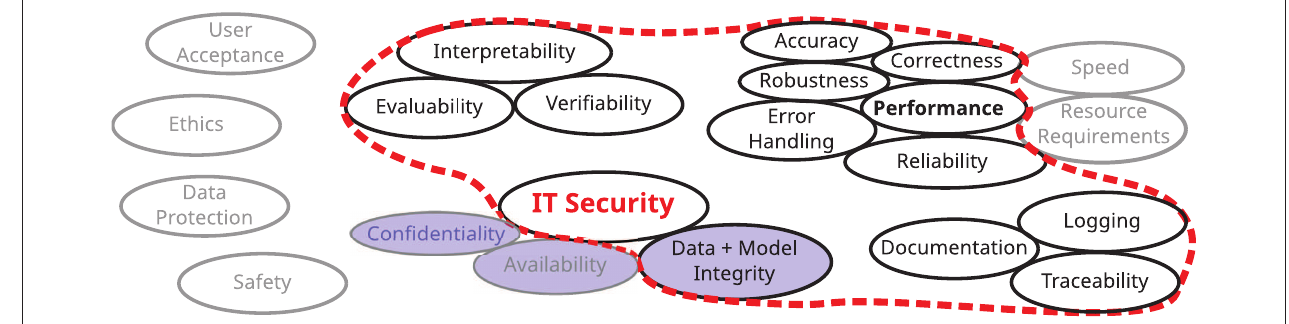
FIGURE 2 | Besides the three core properties confidentiality, integrity, and availability, a holistic view on the IT security of AI applications involves many additional aspects. This paper focuses on data and model integrity and important related aspects, especially robustness, interpretability and documentation, here depicted in the center and encircled with a red line. Note that due to a lack of common definitions and concepts across disciplines, this figure is neither complete nor are the terms used